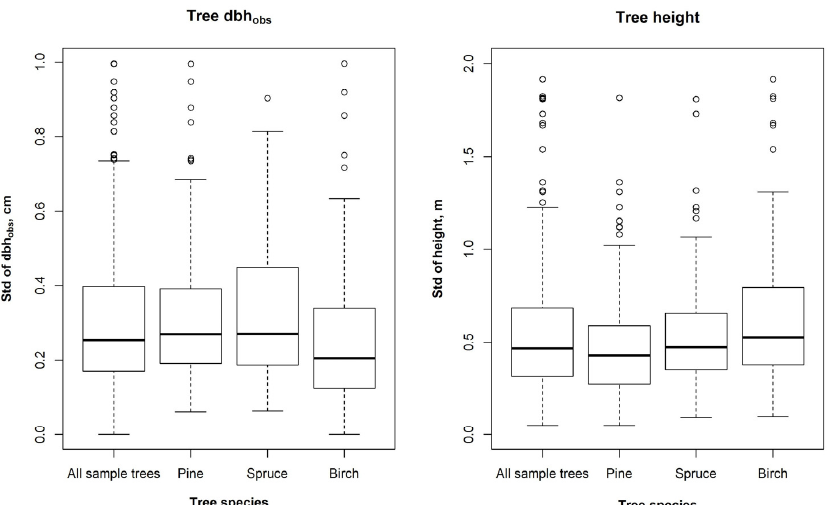
Figure 2. Boxplots demonstrating the variation range of the standard deviation (std) of tree dbh obs (mean of cross measurements) and height measurements from the sample trees in cm and m, respectively. The standard deviations are presented for all the sample trees as well as separately for the tree species. In the figure, the bottom and the top of the box represent the first and third quartiles and the band inside the box is the median. The ends of the whiskers are within 1.5 interquartile of the lower and upper quartiles. The circles represent outliers.